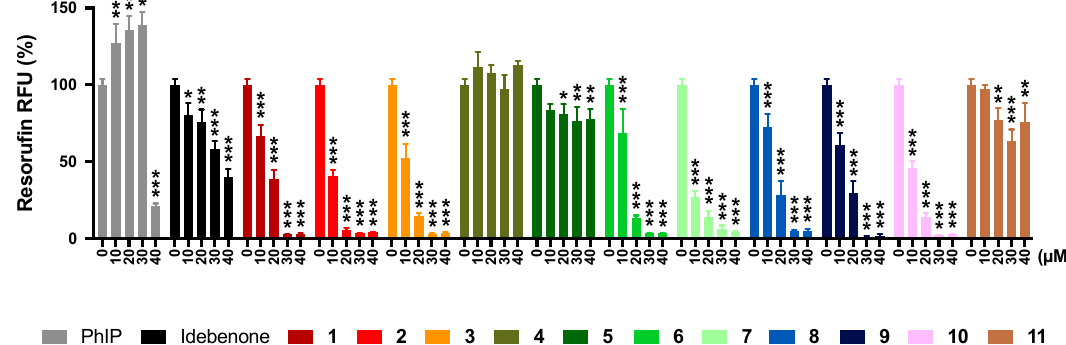
Figure 7. Transformation potential of test compounds. Cells were exposed to reference compounds (PhIP, idebenone) or test compounds (0–40 µ M) for 21 days in soft agar before cell growth under these conditions was quantified. Data represents the mean ± SEM of 8 independent wells per treatment. Two-way ANOVA was performed to compare test concentrations against the non-treated control: *** p < 0.001, ** p < 0.002, * p < 0.033.